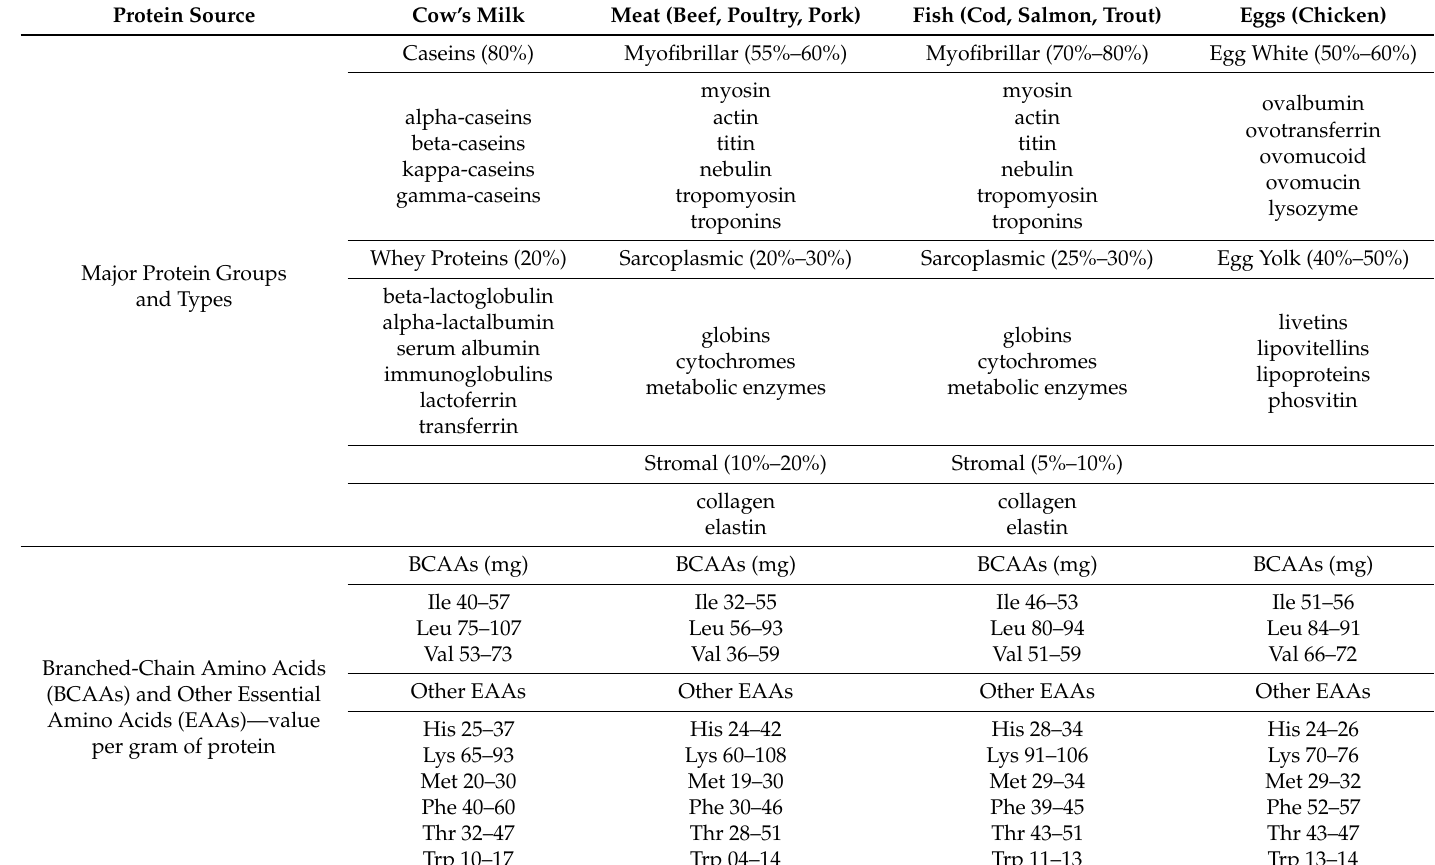
Table 1. Compositional differences between commonly consumed animal